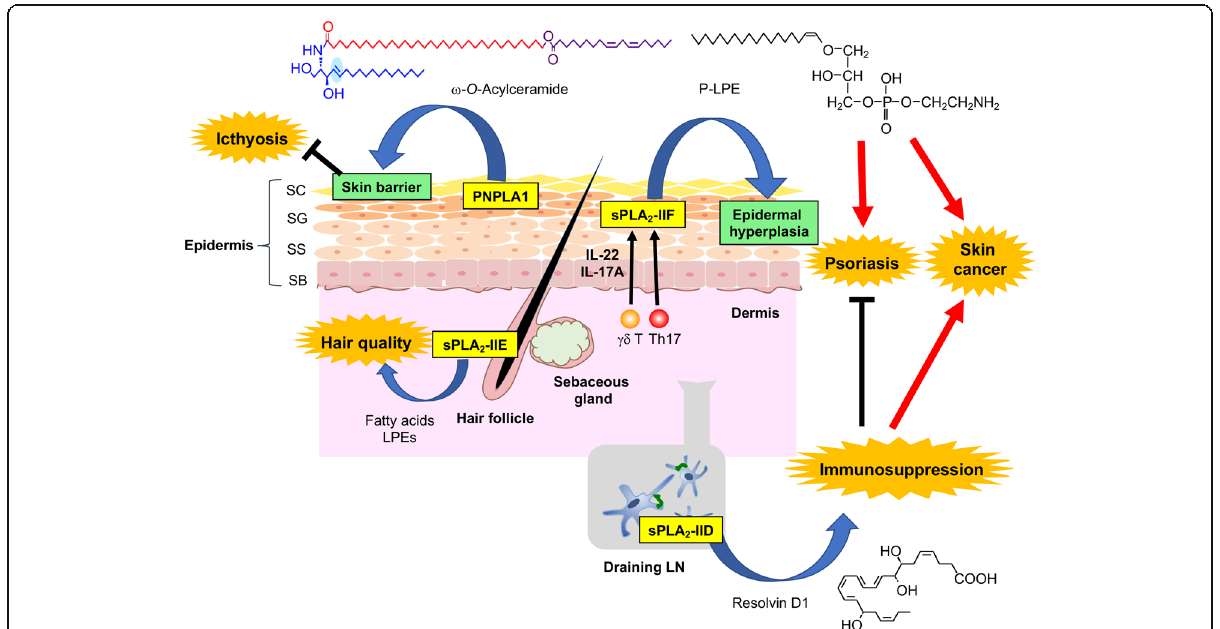
Fig. 1 Expressions and functions of various PLA 2 s in mouse skin. sPLA 2 -IIF is localized in the suprabasal epidermis and produces P-LPE, which promotes epidermal hyperplasic diseases such as psoriasis and skin cancer. Epidermal sPLA 2 -IIF expression and thereby P-LPE production are augmented by IL-17A and IL-22 supplied by γδ T and Th17 cells in psoriasis. sPLA 2 -IIE is localized in hair follicles in synchrony with the growing phase (anagen) of hair cycling and may regulate hair homeostasis. sPLA 2 -IID is constitutively expressed in DCs and M2 macrophages in regional LNs and produces ω 3 PUFA-derived anti-inflammatory lipid mediators, which put a brake on Th1 or Th17 immunity, thereby sequestering CHS and psoriasis and promoting skin cancer. PNPLA1 is expressed in the border of SG and SC, where it produces ω - O -acylceramide that is essential for skin barrier function. For details, please see the